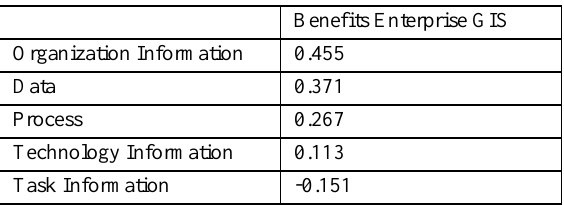
Table 3. Path Coefficients – Benefits Enterprise